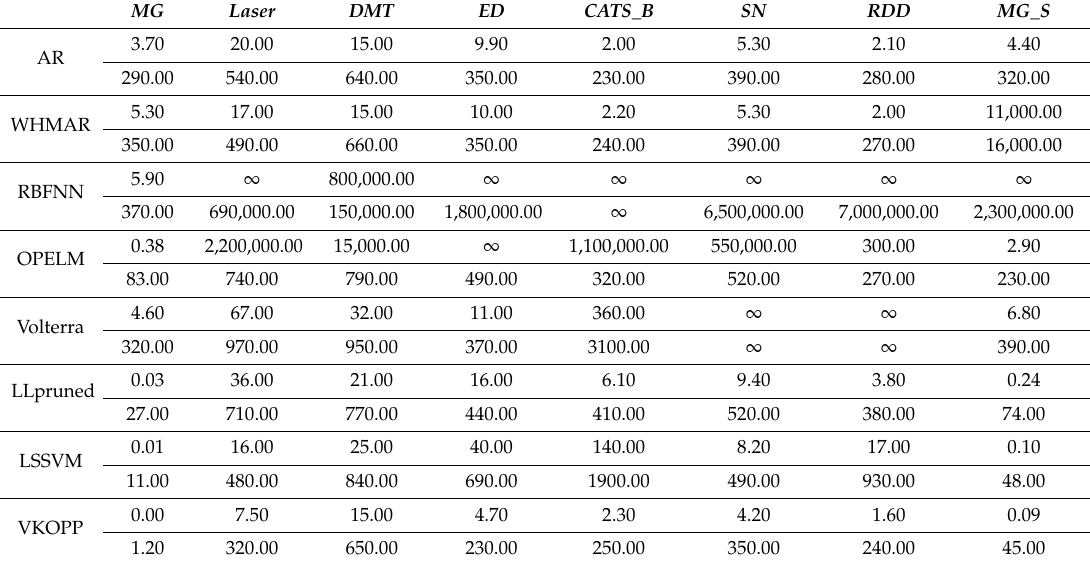
Table 5. Ten-step-ahead prediction: MSE in the top line (NRMSE in the bottom line) for all eight methodologies for eight datasets. ( × 10 − 3